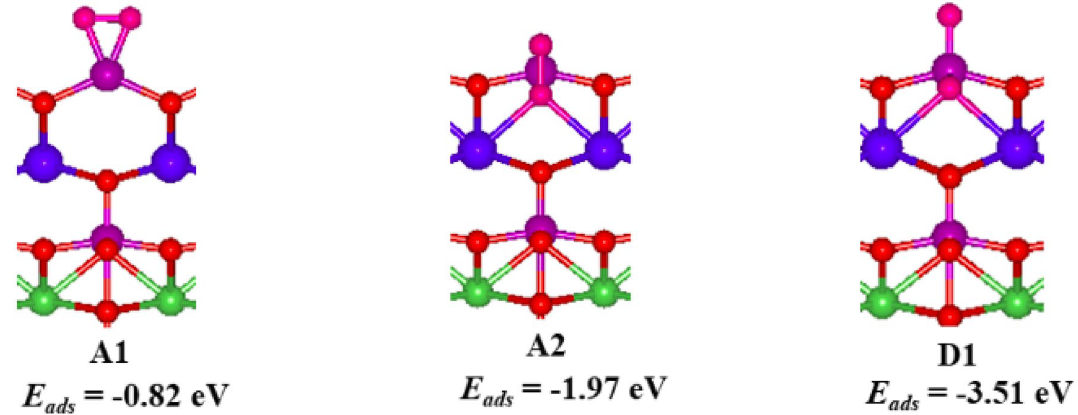
Fig. 6 Side view of the optimized geometries of oxygen molecule on (1 × 1) defective LBM25 {100}. Color code: green = La, blue = Ba, pur- ple = Mn, and red =